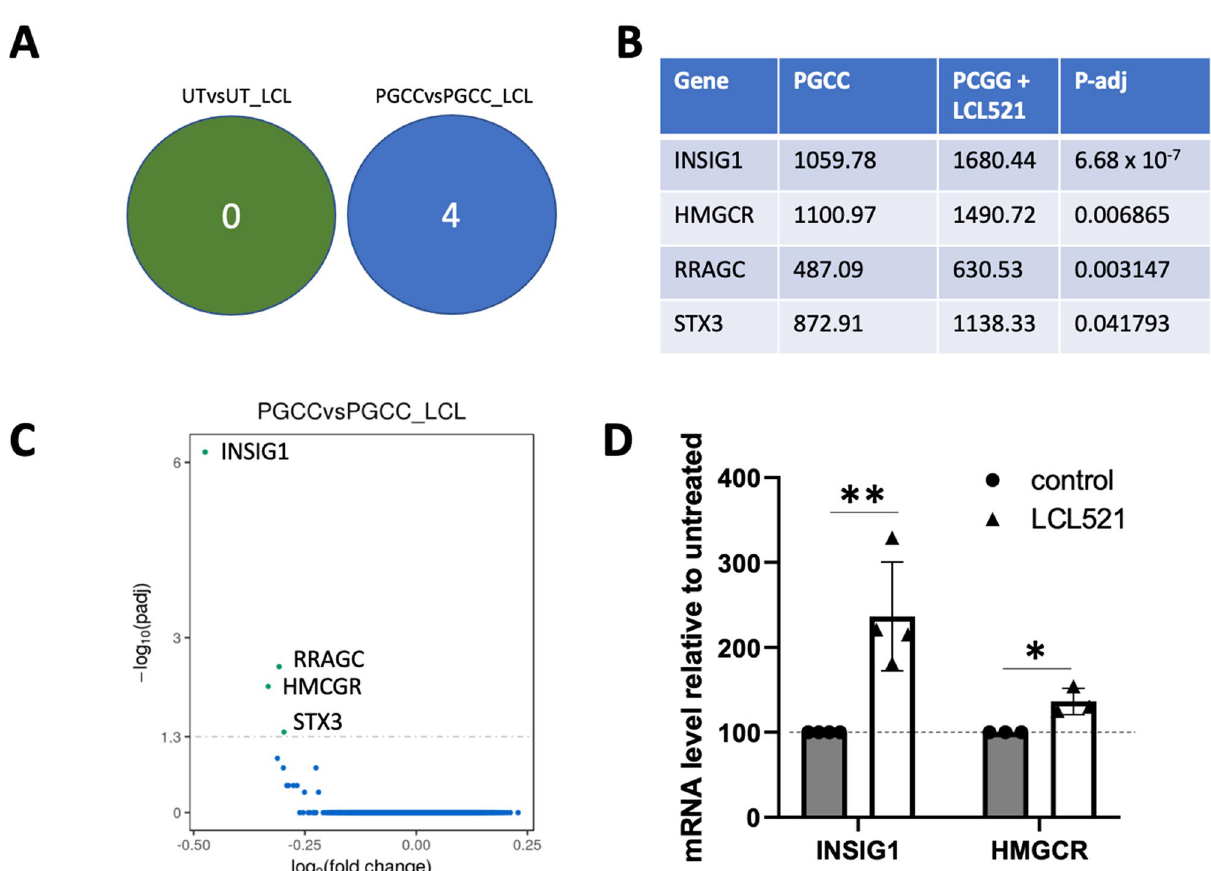
Figure 3. Transcriptomics-identified differences between untreated PGCC and PGCC treated with LCL521 for 5 h. ( A ) Four mRNAs were increased by LCL521 exposure in the PGCC population while none were altered by the drug exposure in the parental PPC1 population. ( B ) Summary of the four upregulated genes in PGCC; all genes were upregulated upon LCL521 treatment. Values in PGCC and PGCC treated with LCL521 as well as the adjusted p-value are shown with p values adjusted using the Benjamini and Hochberg approach for controlling the false discovery rate. ( C ) Graphical representation of change magnitude for the four significantly upregulated mRNAs in PGCC. ( D ) qPCR analysis of HMCGR and INSIG1 in MEL624 PGCC generated through radiation and left untreated or exposed to 5 μM LCL521 for 5